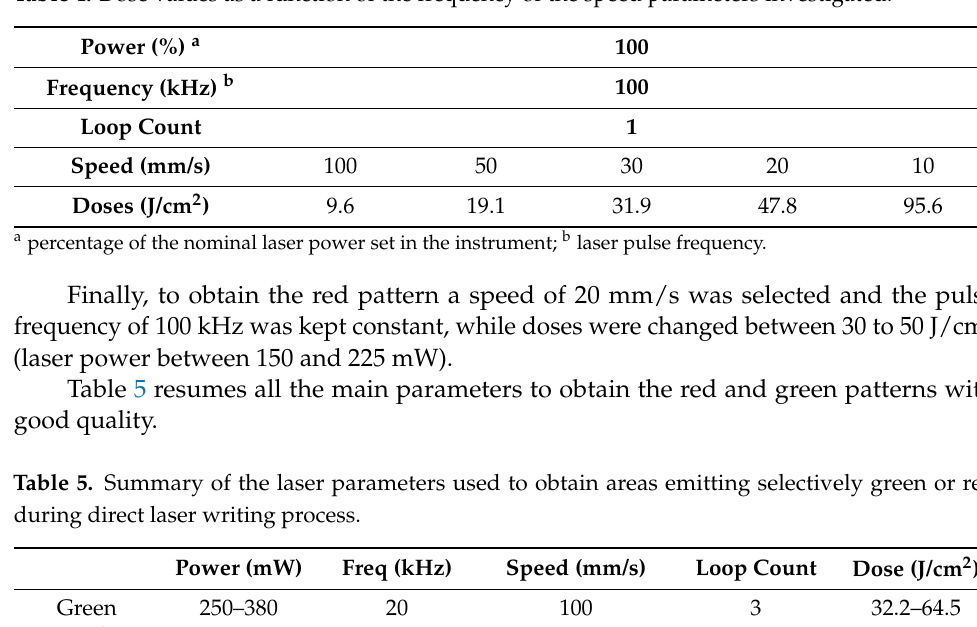
Table 4. Dose values as a function of the frequency of the speed parameters investigated.